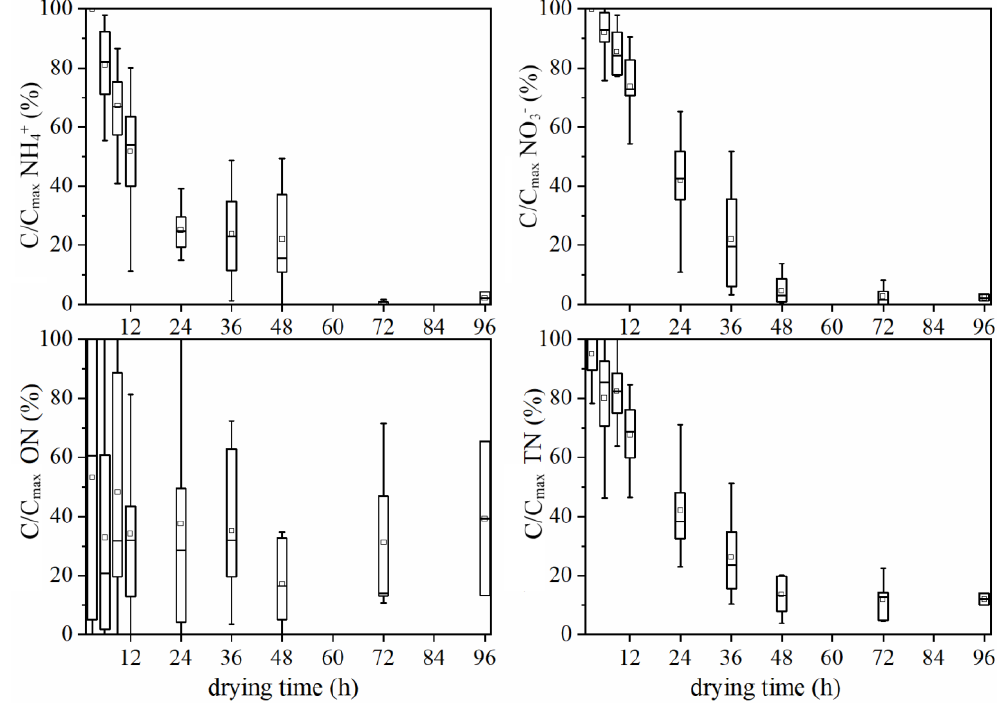
Figure 5. Nitrogen concentration variations in SZ during dry periods (13 events). In each box, the five short lines “-” from up to bottom represent the upper limit value, upper quartile value, median value, lower quartile value, and lower limit value of the data, respectively; the point “ (cid:3) ” represents the mean value of the data.